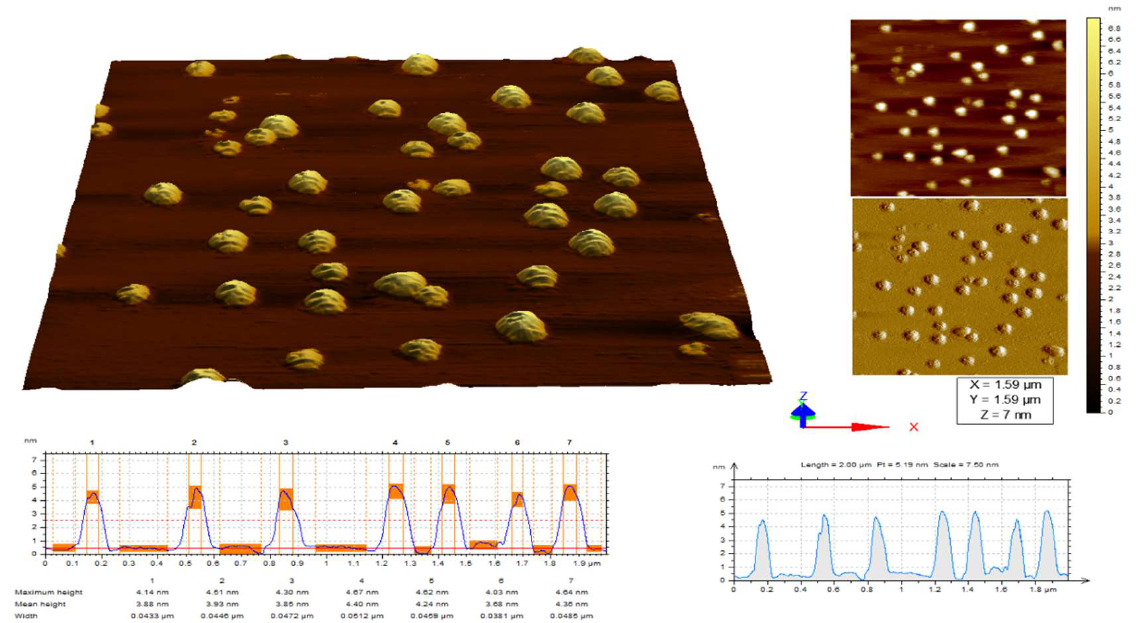
Figure 6. AFM images (2D and 3D) of Priestia aryabhattaii -synthesized Ag NPs.